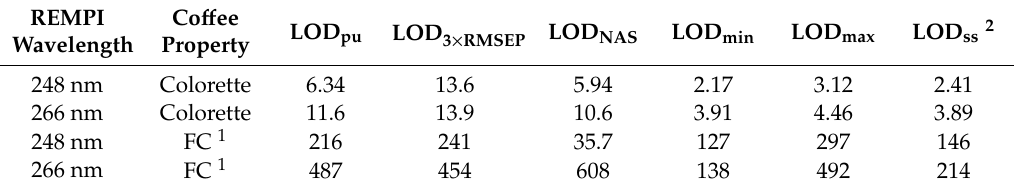
Table 3. Figures of merit: Limit of detection